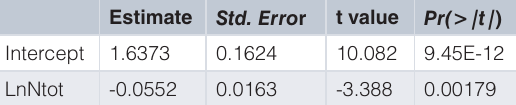
Table 2. Results of the simple linear regression analysis between the population growth rate ( λ ) as dependent variable, and (in log scale) total guanaco population ( LnNtot ). The interpretation of the statistical parameters are as in Table